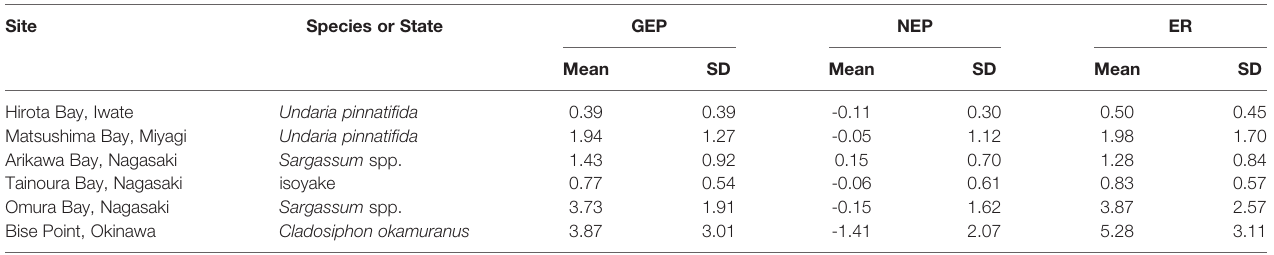
TABLE 2 | The mean and one standard deviation (SD) of the observed rates of gross ecosystem production (GEP), net ecosystem production (NEP), and the ecosystem respiration (ER) determined from three seaweed aquaculture farms ( Undaria pinnatifda and Cladosiphon okamuranus ) and three natural ecosystems in Japan. Site